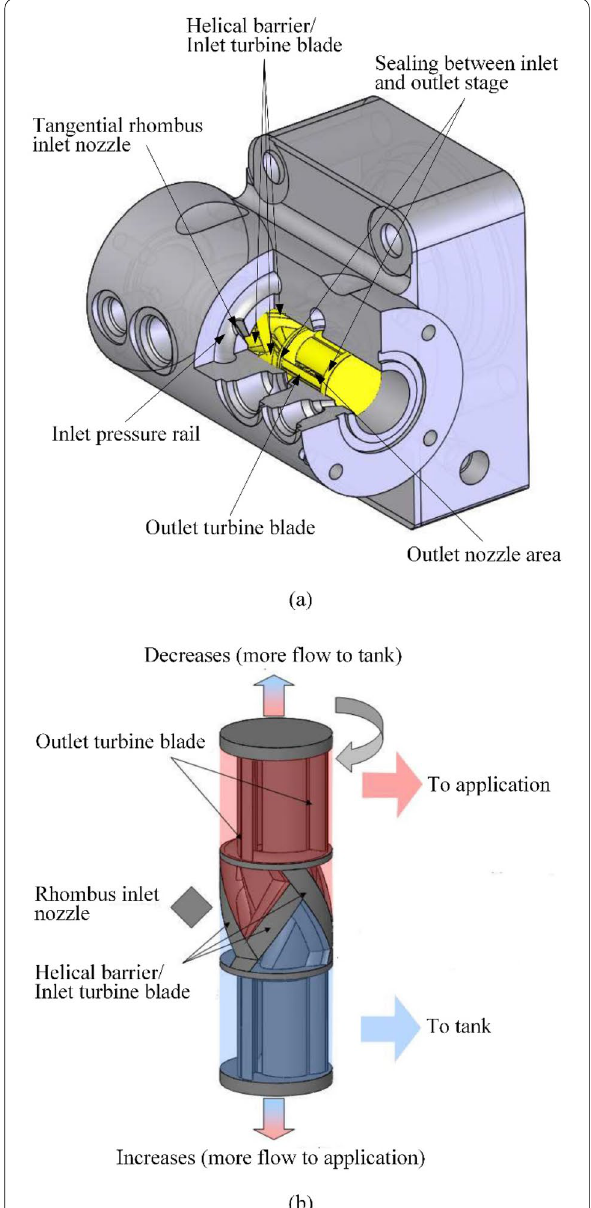
Figure 3 Self-spinning rotary valve provided by Tu et al.: a cutaway illustration on the assembly of spool and sleeve, b schematic of the rotary